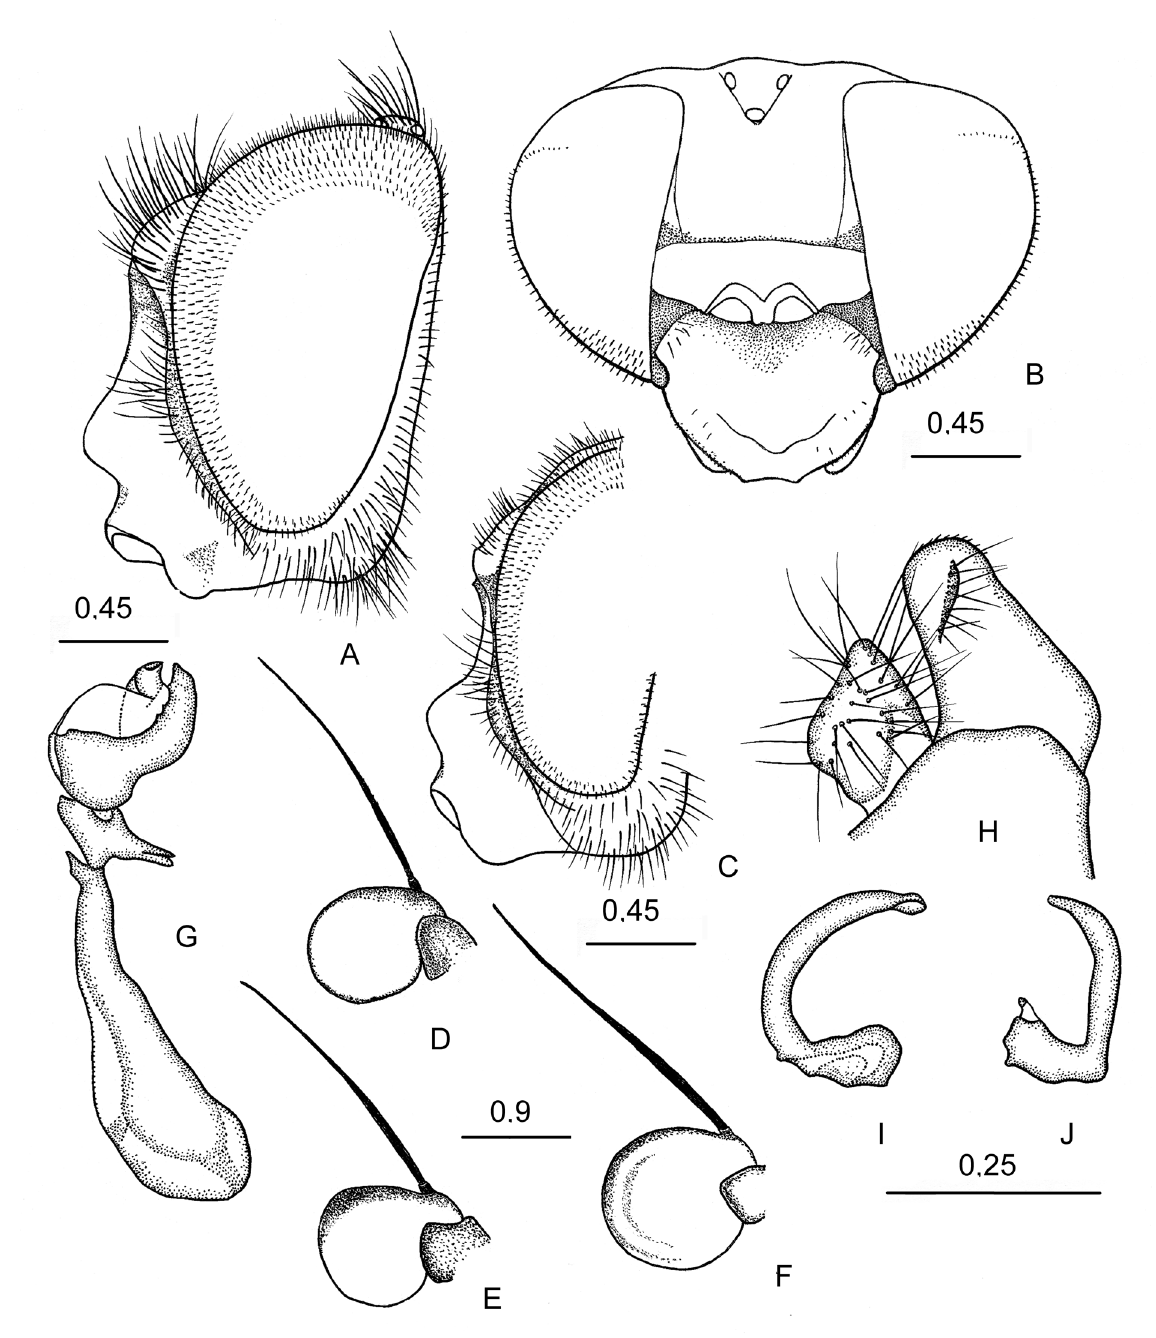
Fig. 68. Cheilosia ( Neocheilosia ) komabaensis Shiraki, 1968; A, D–E, G–J = ♂, B–C, F = ♀. A, C . Head, lateral view. B . Head, dorsal view. D–F . Antenna, lateral view of pedicel and basoflagellomere. G . Aedeagus and aedeagal apodeme, lateral view. H . Surstylus and gonocercus, lateral view. I–J . Superior lobes of hypandrium, lateral view. After Barkalov & Ichige 2016. Scale bars indicated in